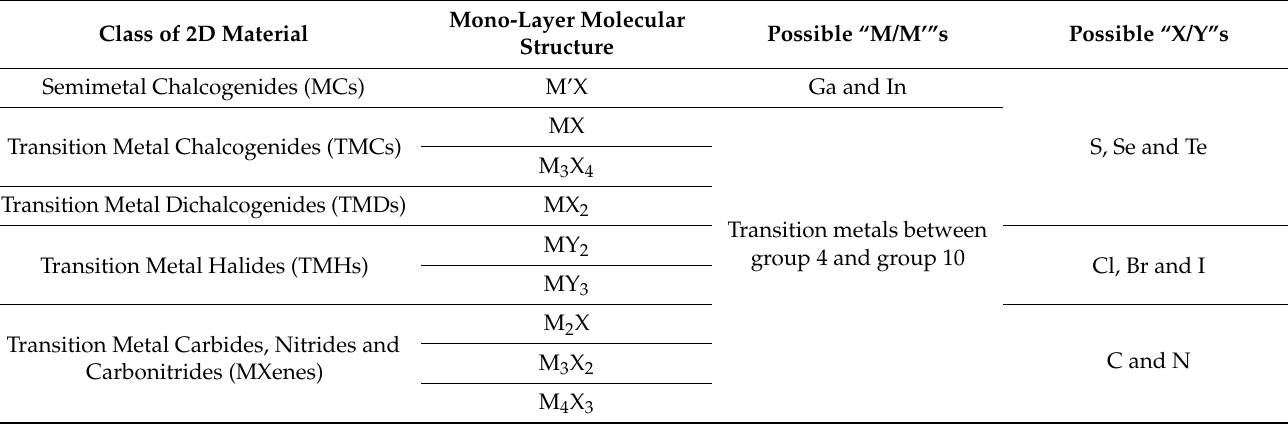
Table 2. Atlas of 2D materials based on metals and transition